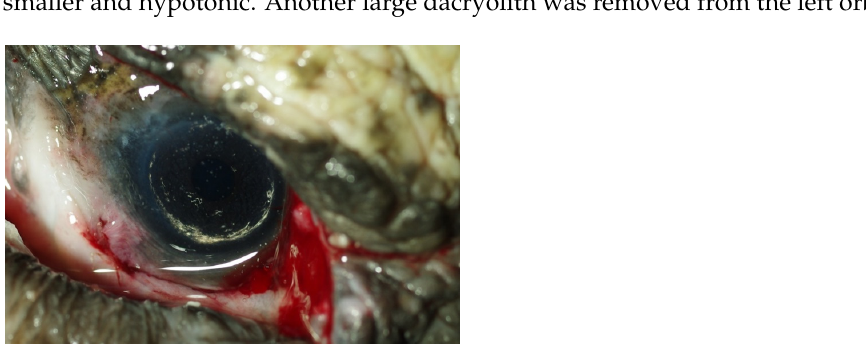
Figure 5. Ultrasonography of the left eye, vertical scan: a normal lens is visible (4.6 mm, the space between the electronic calipers “+”) but not the anterior chamber; the cornea is thickened and without the normal doubled layer structure (arrow).